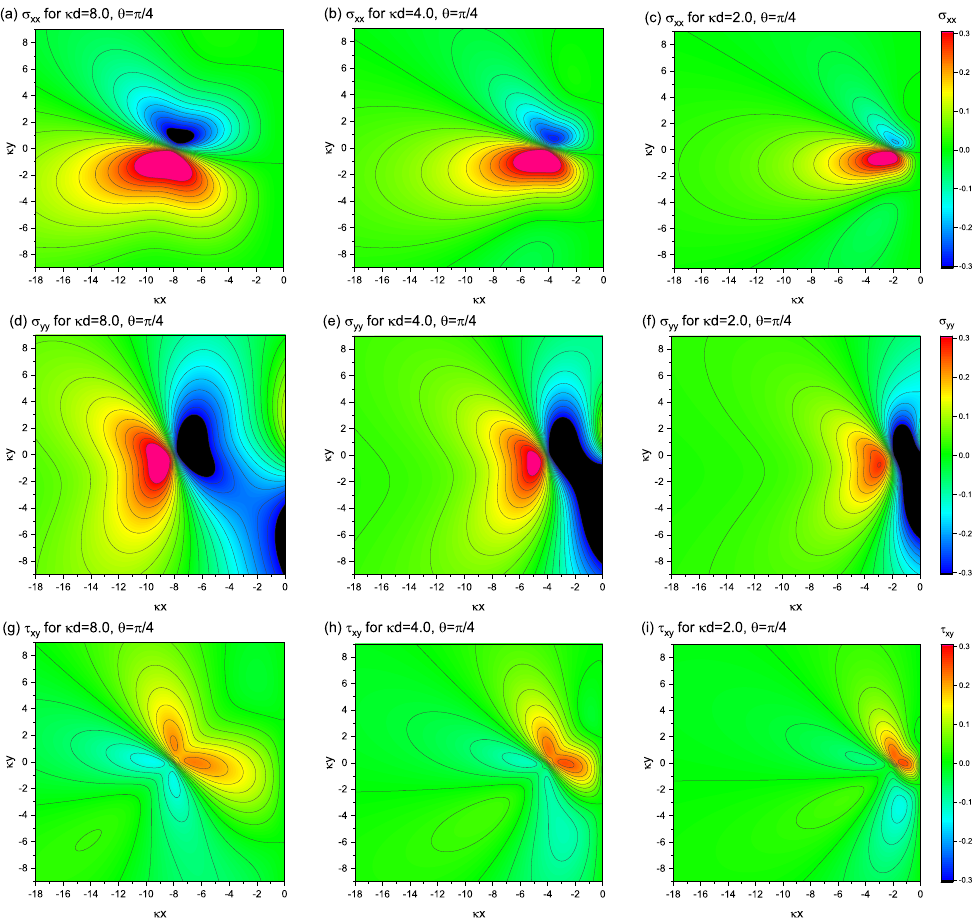
Figure 5. Nonsingular stress fields of an edge dislocation at ( x , y ) = ( − d ,0 ) with the angle θ = π /4 between the Burgers vector and the x -axis. Upper row: ( a – c ) σ xx ( x , y ) . Middle row: ( d – f ) σ yy ( x , y ) . Bottom row: ( g – i ) τ xy ( x , y ) . The units of stress and length scales are the same as in Figure